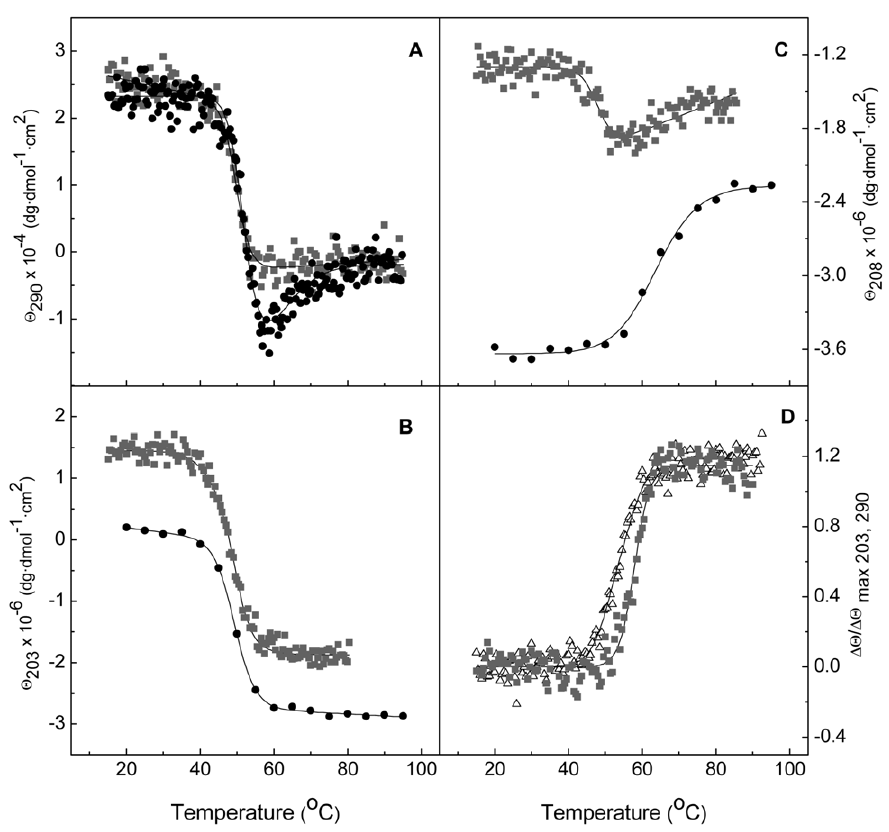
Figure 4. Comparison of the full-length protein and the CM thermal transitions. ( A ), ( B ) and ( C ) compare the CD denaturation profiles of Cpl-7 (black circles) and the CM alone (greysquares) monitored at 290 nm, 203 nm and 208 nm, respectively, in 20 mM Pi buffer pH 7.0 (scan rate of 40 u C h 2 1 ). For comparison, ellipticities per mole of molecule were used instead of the average molar ellipticities per residue. ( D ) shows the differences in the relative ellipticity vs temperature profiles at 290 nm (squares) and 203 nm (triangles) for the CM denaturation at pH 6.0. The continuous traces are the curves calculated as indicated in the text with the best fitting parameters (Tables 1 and 2).